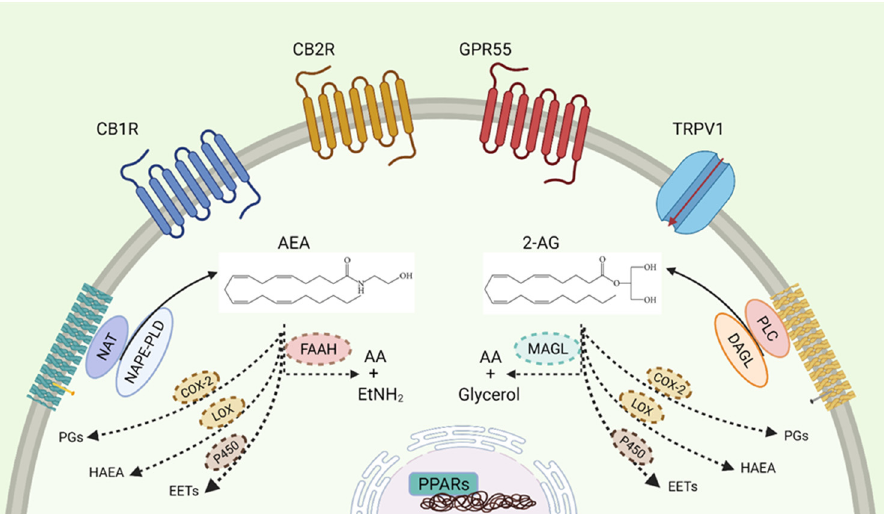
Figure 1. The components of endocannabinoid system. The two principal bioactive lipids (AEA, 2-AG), the receptors (CB1R, CB2R, GPR55, TRPV1, and PPARs) and the biosynthetic (NAPE-PLD or DAGL) and catabolic enzymes (FAAH, MAGL or alternative oxidising enzymes) are shown. Created with BioRender.com.